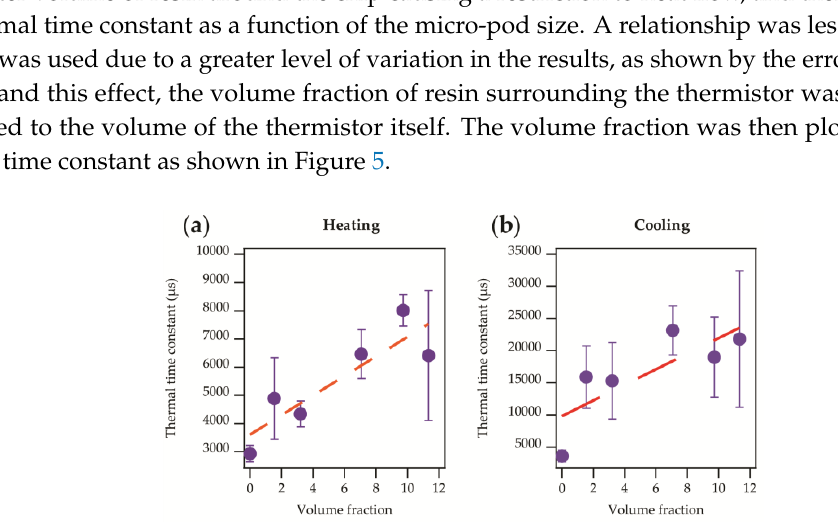
Figure 5. Thermal time constant against the volume fraction of resin surrounding the thermistor compared to the thermistor’s volume. Data presented shows when samples were directly attached to the hotplate ( ; previously shown in Figure 4a). ( a ) Heating thermal time constant. A direct linear relationship (r 2 = 0.776) is observed as shown in Equation (5); ( b ) Cooling thermal time constant. The linear relationship (r 2 = 0.629) observed is shown in Equation (6).